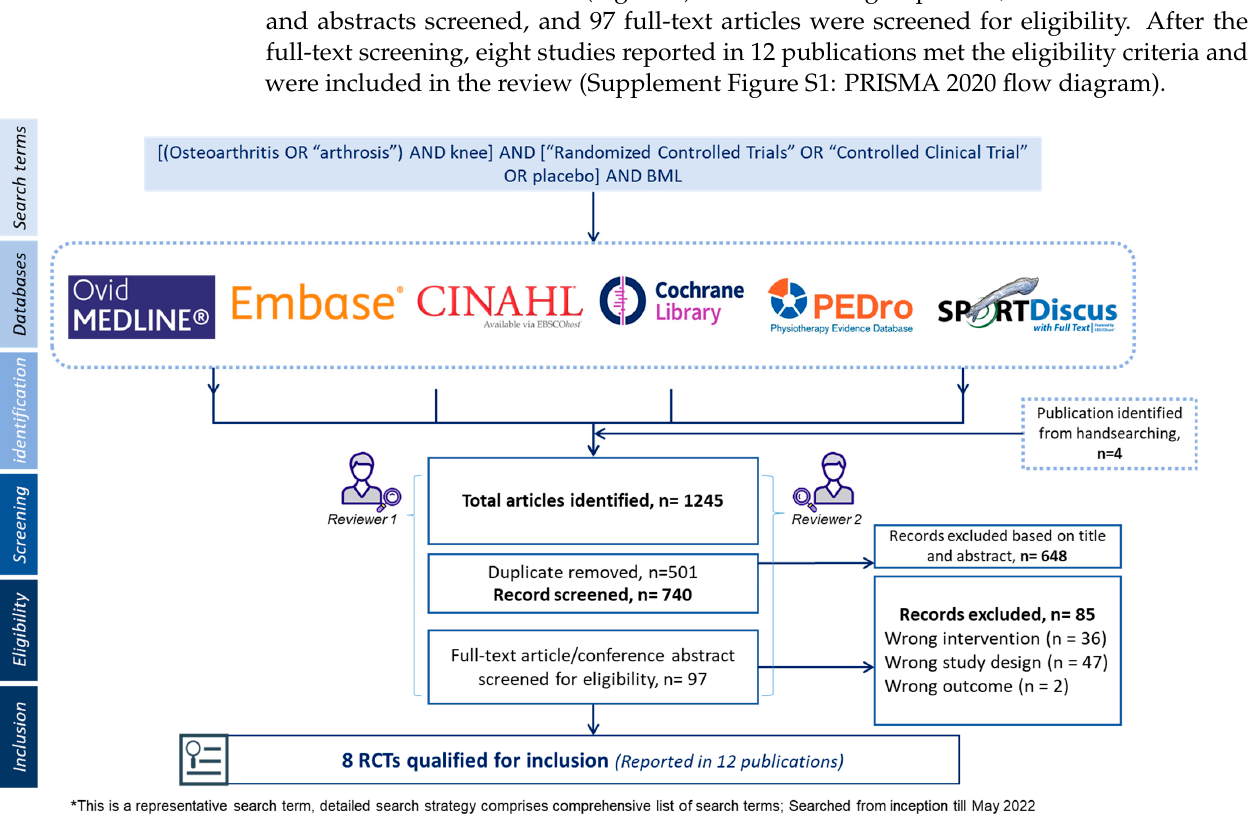
Figure 1. Flow chart describing method and inclusion of studies.